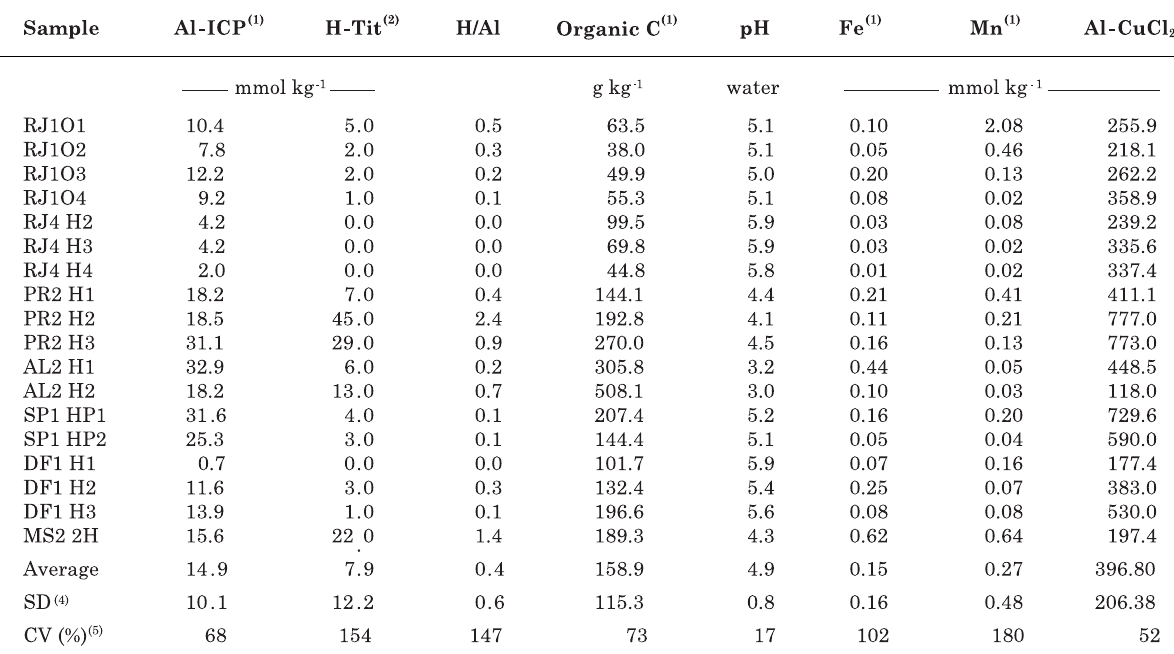
Table 3. Some chemical analyses of 19 organic soil samples